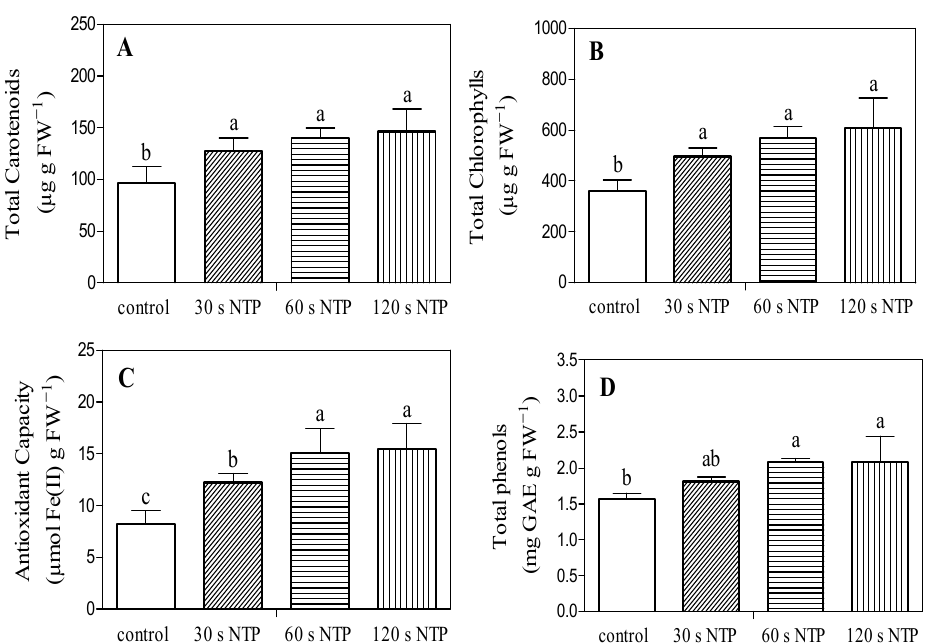
Figure 5. Effect of NTP treatment (0, 30, 60 or 120 s every hour) of nutrient solution on leaf content of carotenoids ( A ), chlorophylls ( B ), antioxidant capacity ( C ), and total phenols ( D ) in lettuce plants grown in indoor hydroponic system for nine days. Each value is the mean of three replicates (± SE). Different letters indicate significant differences between treatments according to LDS test at 5% level.